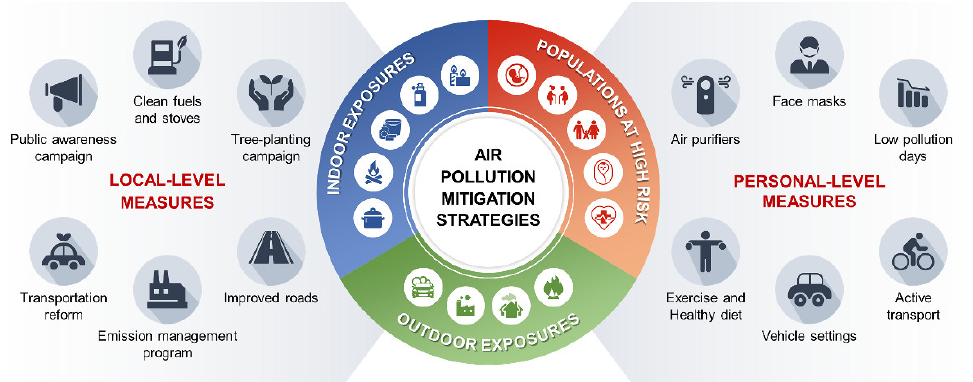
Figure 3. Local- and personal-level mitigation measures to reduce exposure to air pollution. The figure presents important elements related to reducing air pollution exposure and protecting respiratory and cardiovascular health. Sources contributing to both ambient and household air pollution are shown. Populations at high risk with exposure to air pollution include pregnant women, elderly individuals, children, newborns, and people with preexisting health conditions.